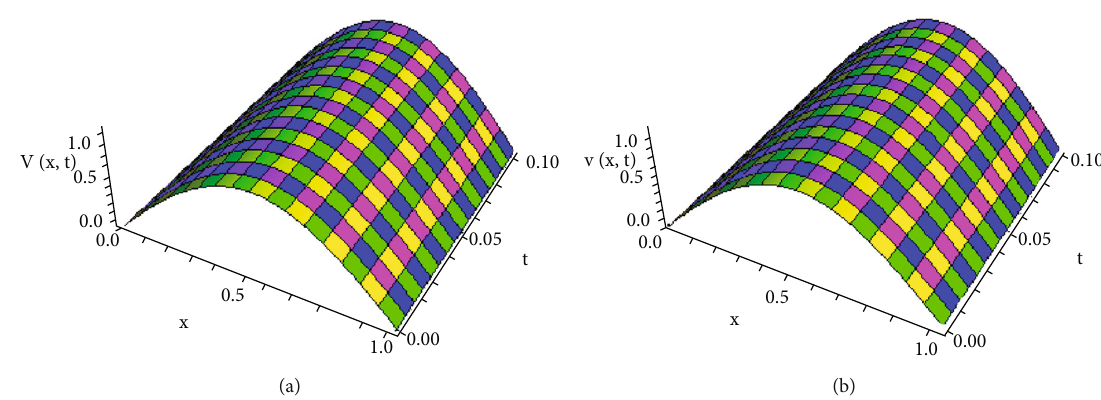
Figure 5: The approximate and exact solutions for Example 6 when h = 1/60, t = 0 : 1, Δ t = 0 : 01 .